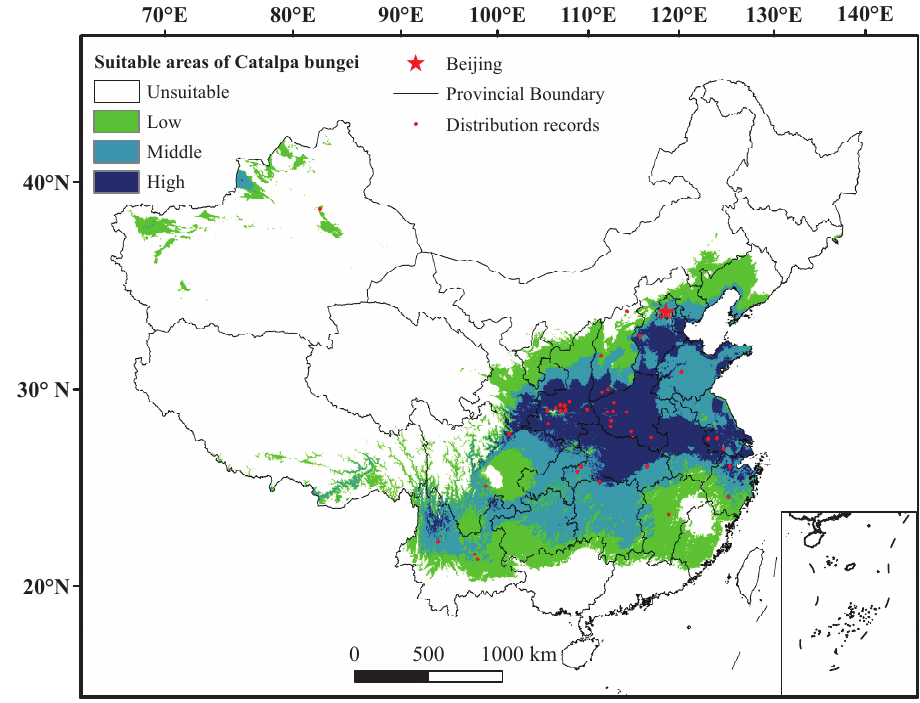
Figure 3. The potential distribution of C. bungei under current